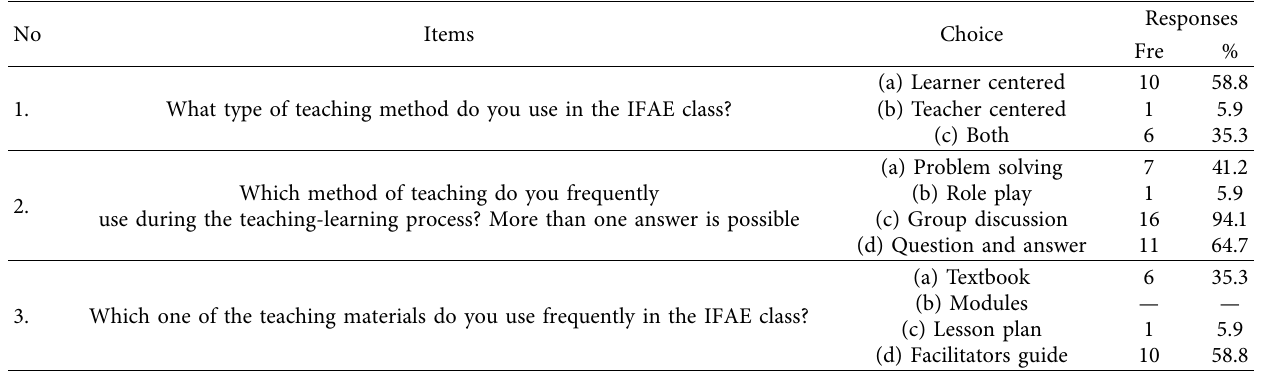
Table 2: Facilitator’s response related to methods used in the IFAE